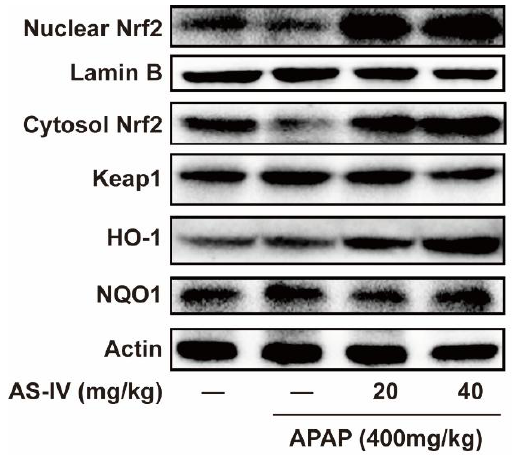
Figure 6. AS-IV activated Nrf2 signaling pathway ( n = 3). Western blotting analysis of Nrf2, Keap1, HO-1, and NQO1.